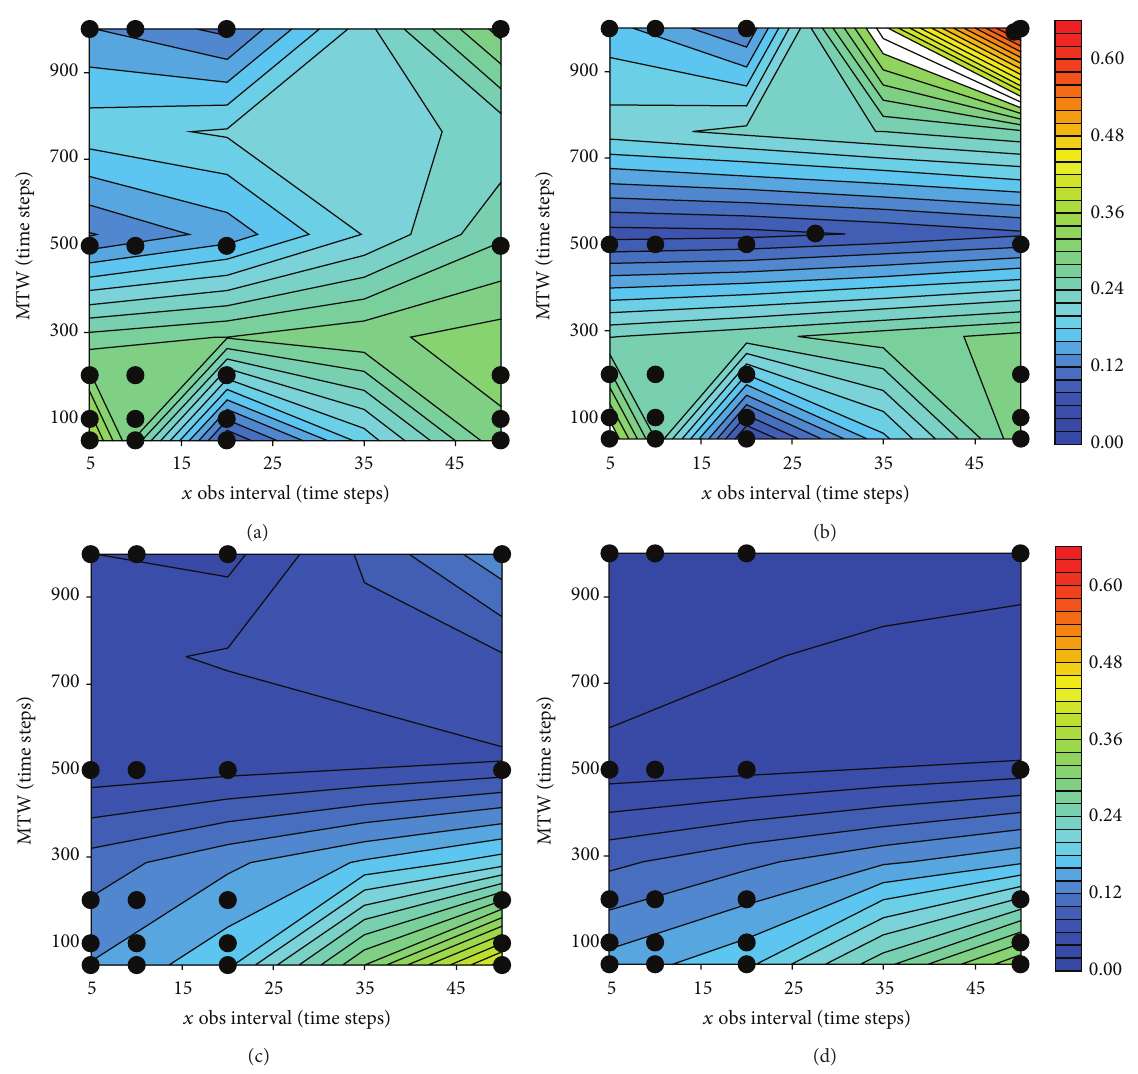
Figure4:Time-averagednormalizedabsoluteerrorsof 𝑐 1 𝑤 in(a)EXP-1,(b)EXP-2,(c)EXP-3,and(d)EXP-4ofthe4D-VarCPE.Theabsolute error of 𝑐 1 𝑤 is normalized by its climatological standard deviation (0.15). All panels use the same shade